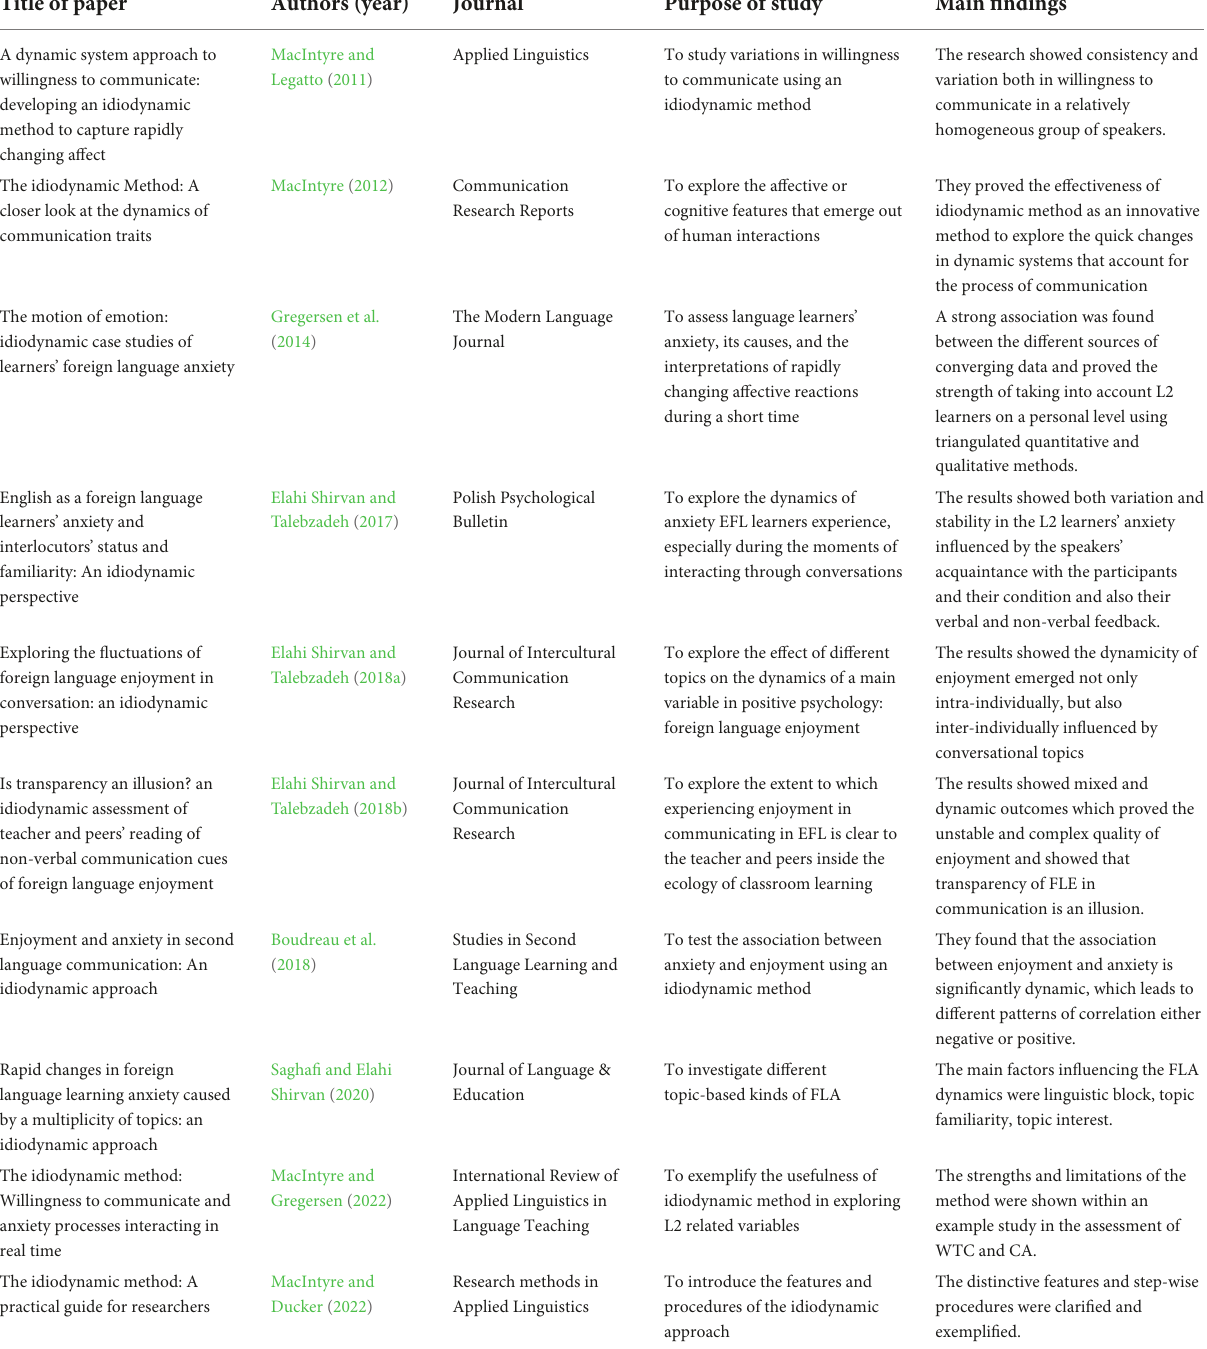
TABLE 1 A summary of the literature of the idiodynamic method and L2 affective